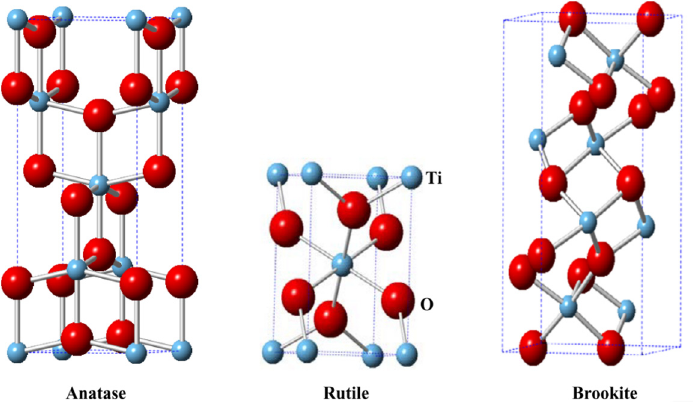
Figure 13. Crystal structure of anatase, rutile, and brookite [43]. Reproduced with permission from Etacheri et al. Copyright © 2022 Elsevier.